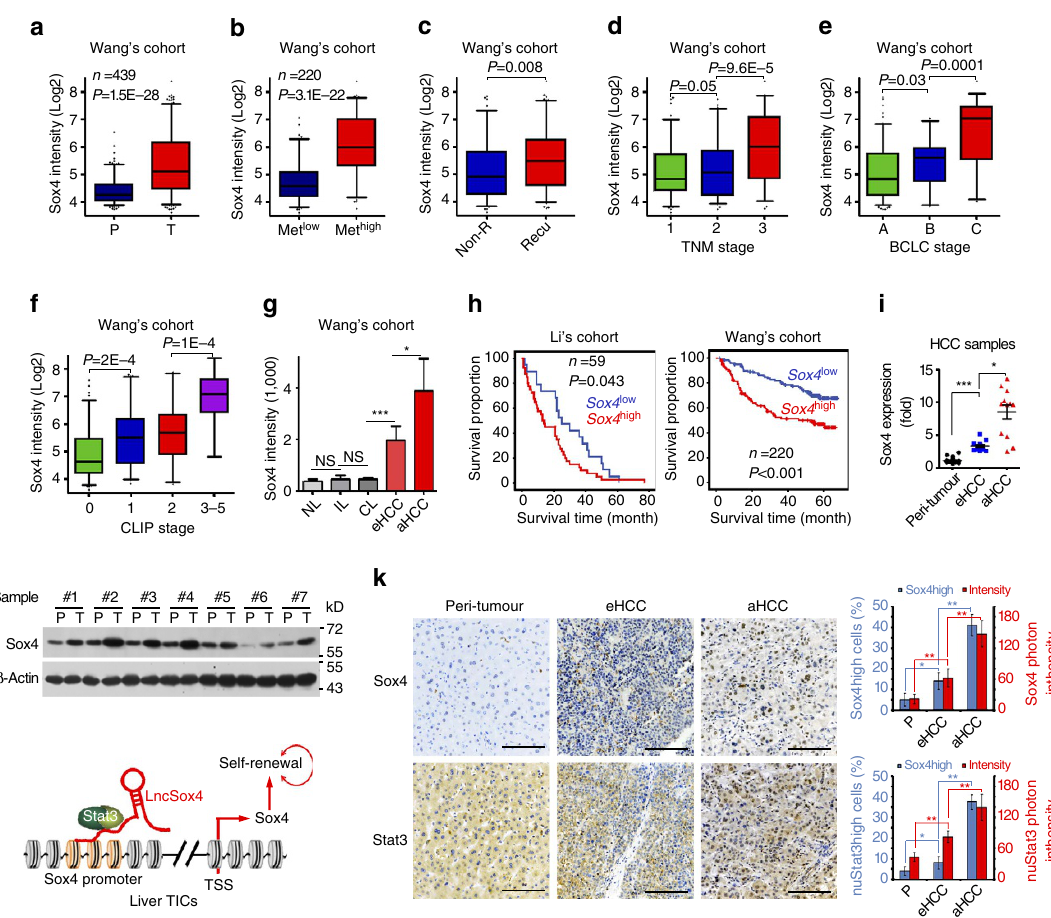
Figure 7 | Sox4 expression levels are related to HCC severity and prognosis. ( a ) High expression of Sox4 in liver cancer tissues according to Wang’s cohort. R language and Bioconductor were used for gene expression analysis derived from Wang’s cohort. ( b ) Sox4 is highly expressed in metastasis samples. Tumour samples were divided into two groups according to metastasis properties, and Sox4 expression levels were analysed. ( c ) Sox4 expression levels are related to recurrence. Recurrent and non-recurrent samples were selected and Sox4 expression levels were compared. ( d – f ) High expression of Sox4 in serious HCC samples. The samples were divided according to TNM stage ( d ), BCLC stage ( e ) and CLIP stage ( f ), and Sox4 expression levels were analysed. BCLC, Barcelona Clinic Liver Cancer; CLIP, Cancer of the Liver Italian Program; TNM, tumour node metastasis. ( g ) Increased Sox4 expression levels in liver tumorigenesis. aHCC, advanced HCC; CL, cirrhosis liver; eHCC, early HCC; IL, inflammatory liver; NL, normal liver. ( h ) Sox4 expression is related to HCC prognosis. The samples were grouped according to Sox4 expression levels and Kaplan–Meier survival analyses were performed. ( i – k ) High expression of Sox4 in HCC was confirmed by real-time PCR ( i ), western blot ( j ) and IHC ( k ). Primary HCC samples were obtained and marked according to obtaining time. mRNA was extracted for real-time PCR ( i ), cell lysate was used for western blot ( j ), and formalin-fixed tissue sections were used for IHC ( k ). Scale bars, 100 m m. ( l ) Working model. In liver TICs, LncSox4 is highly expressed and binds to Sox4 promoter. LncSox4 recruits Stat3 to Sox4 promoter and drives Sox4 expression, which is required for liver TIC self-renewal and related to HCC severity and prognosis. For a – f , data were shown as box and whisker plot. Box, interquartile range (IQR); whiskers, 5–95 percentiles; horizontal line within box, median. For g , i and k , data were shown as means ± s.d. Two-tailed Student’s t -test was used for statistical analysis. * P o 0.05; ** P o 0.01; *** P o 0.001. P o 0.05 was considered significant. For j , the original images are shown in Supplementary Fig. 6. NS, not liver cancer progression and prognosis, providing a new potential marker for HCC diagnosis and prognosis.